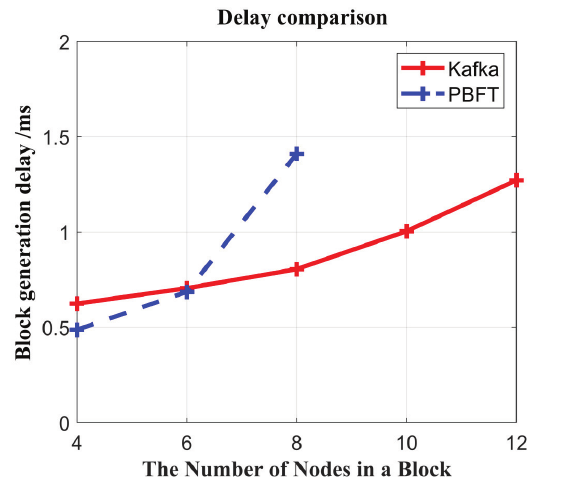
Figure 10. Comparison of delays in block generation under two consensus algorithms.